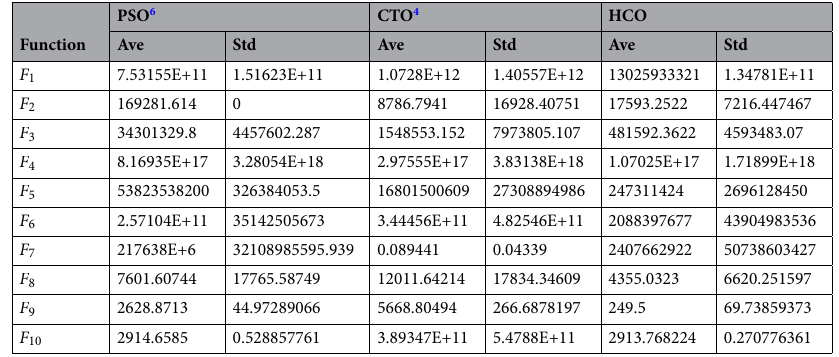
Table 5. Convergence performance of HCO for 500 dimensional CEC 2020 benchmark